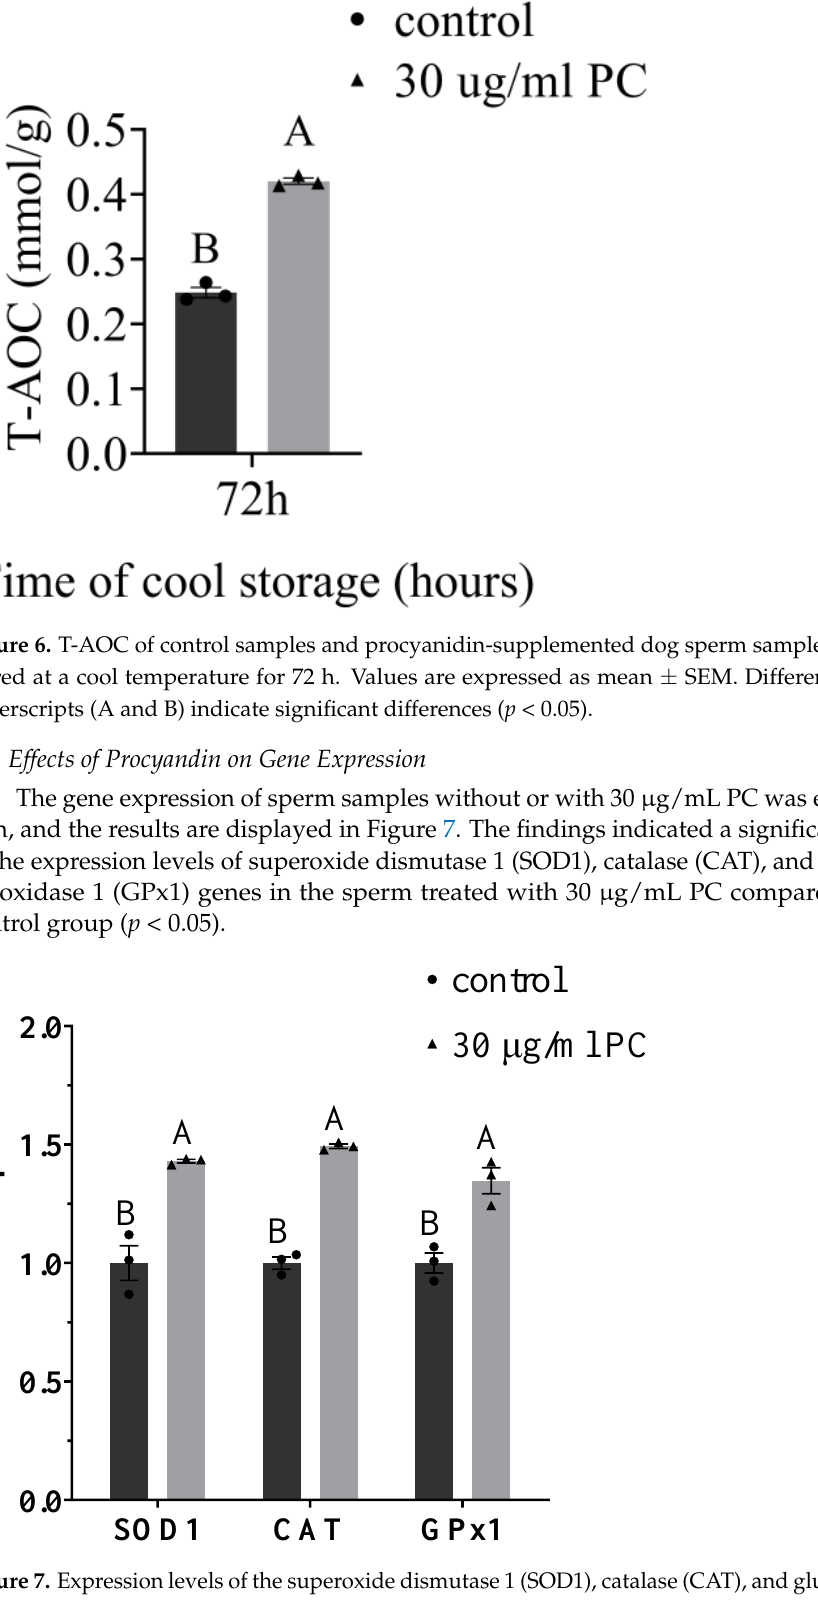
Figure 7. Expression levels of the superoxide dismutase 1 (SOD1), catalase (CAT), and glutathione peroxidase 1 (GPx1) genes in control samples and procyanidin-supplemented dog sperm samples using real-time quantitative polymerase chain reaction (RT-qPCR). Values are expressed as mean ± SEM. Different uppercase superscripts (A and B) indicate significant differences ( p < 0.05).